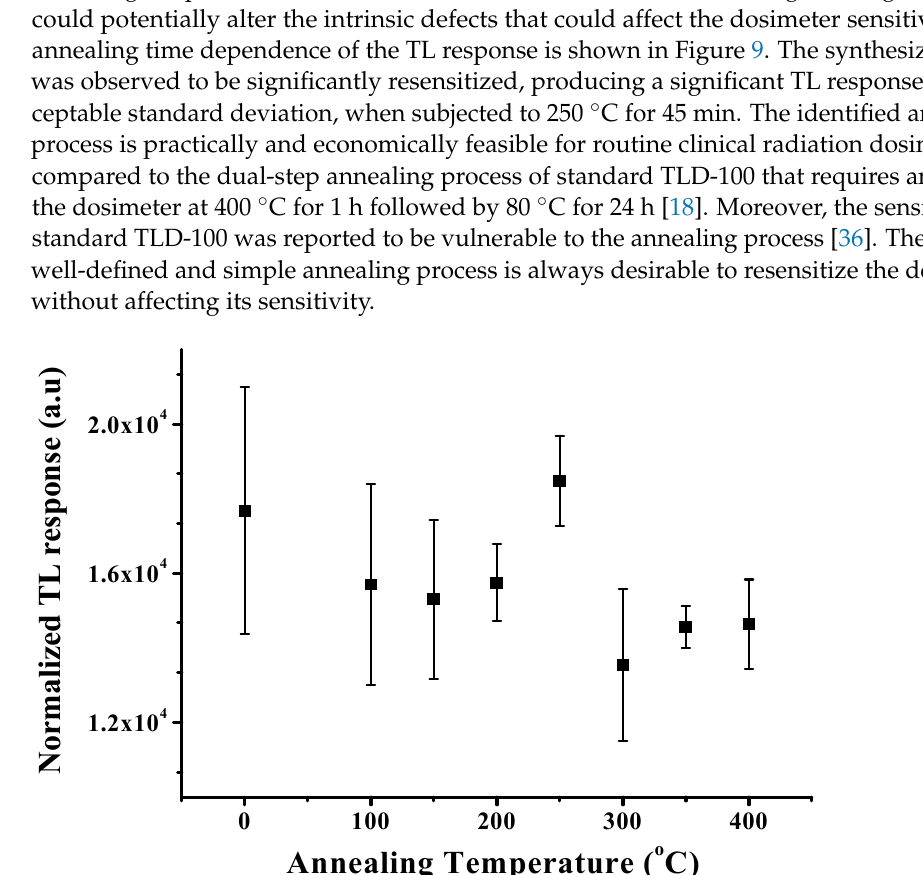
Figure 8. Effect of annealing temperature on TL response of MgB 4 O 7 :Zn glass S35654.